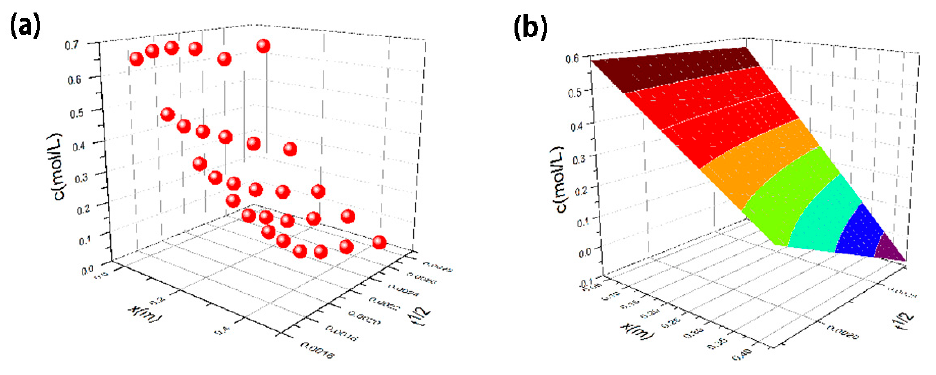
Figure 8. ( a ) The original experimental data and ( b ) the fitted surface according to Equation (3). Table 2. The one-dimensional model of Fick’s second law.